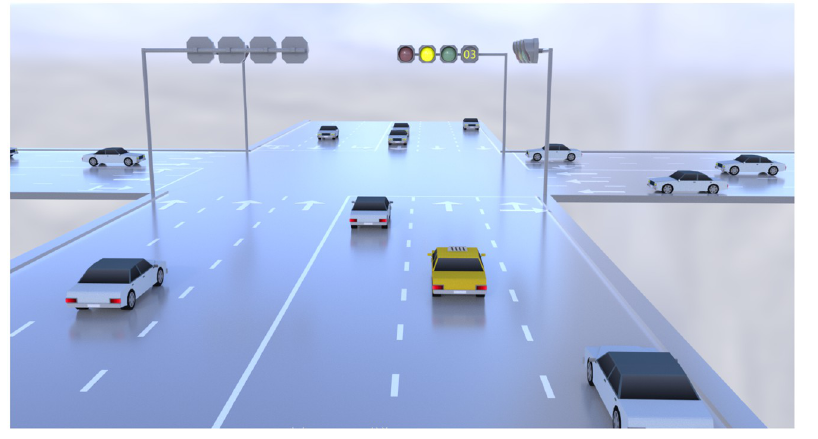
Fig 1. Experimental